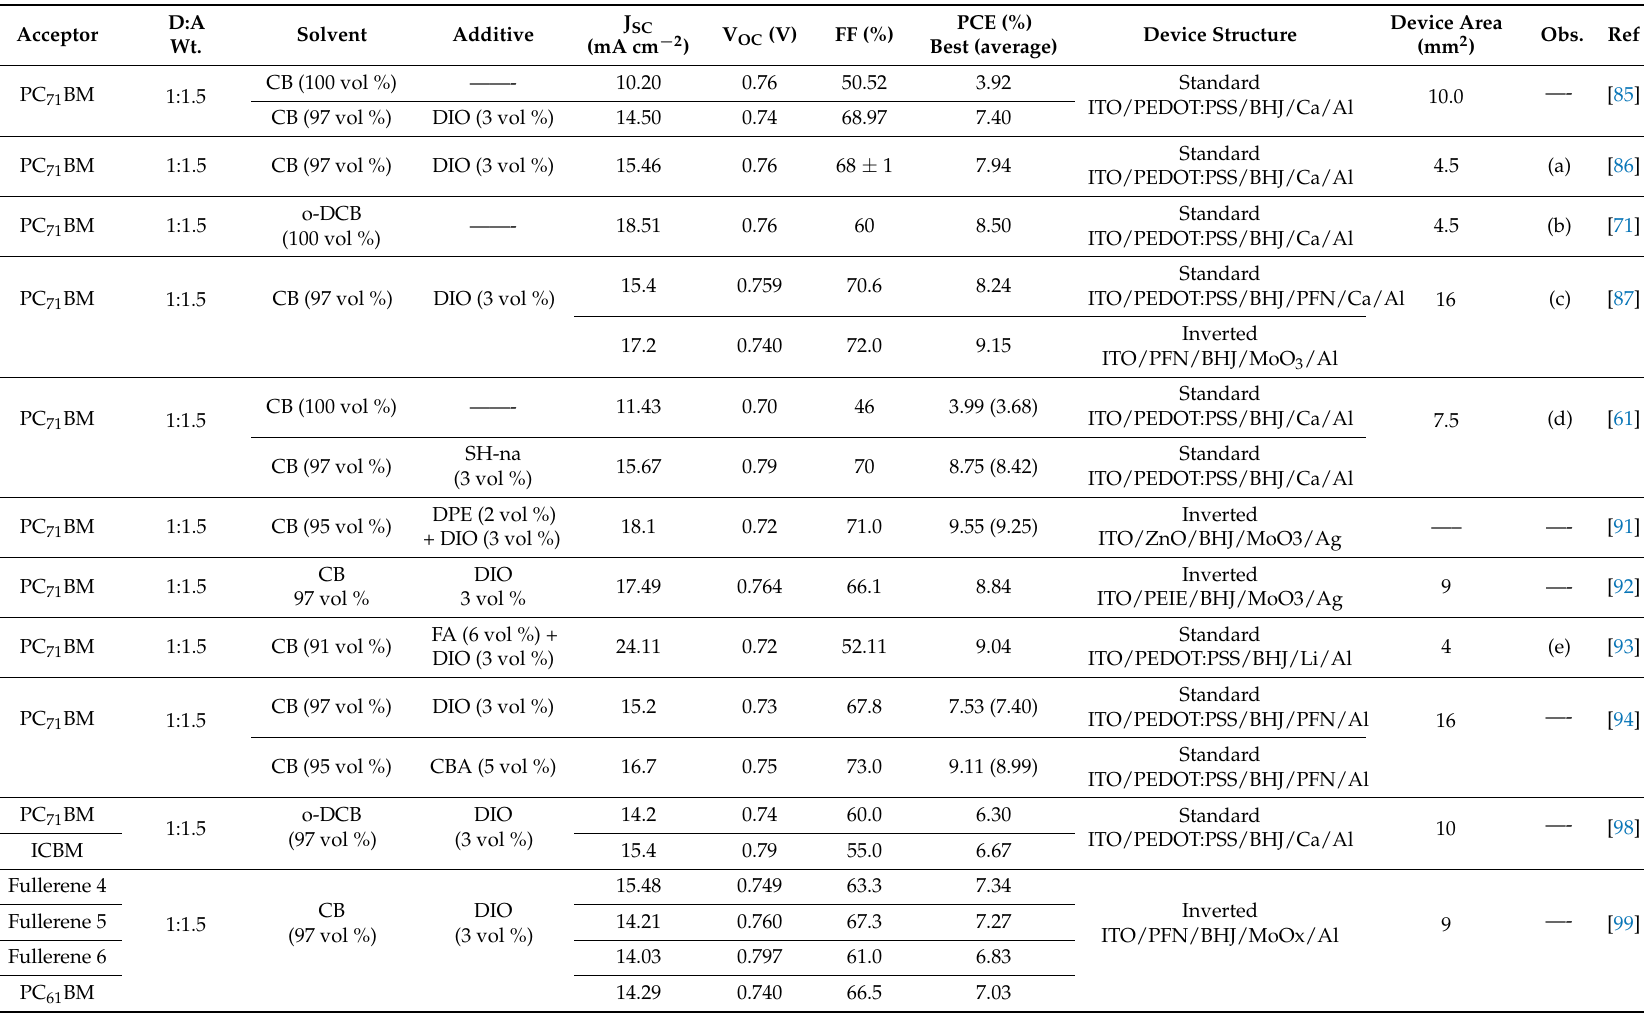
Table 1. Summary of the most relevant device figures of merit and efficiency results obtained with PTB7:fullerene